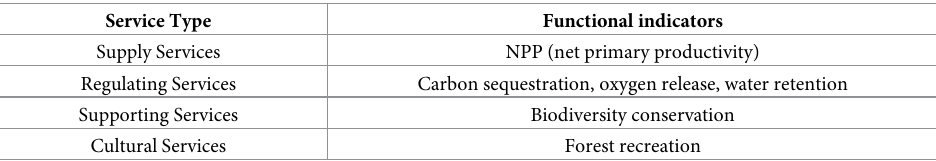
Table 2. Forest ecosystem service function